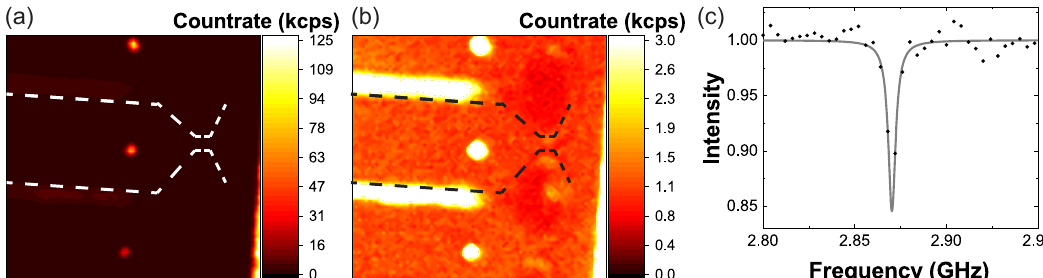
Figure 6. ( a , b ) PL map of SCD platforms with individual nanopillars fabricated with the process described in Section 4. The outer edge of the holding platform is indicated using a dashed line, while the pillars appear as bright spots. To enable comparing the background PL from the platforms with the PL of a few NV − centers in the pillars, we show the same PL map with two different scaling: individual NV − centers in the pillars show PL countrates above 125 kcps at an excitation power of 500 µ W at 532 nm ( a ). ( b ) It is clearly discernible that the cantilevers show only a weak PL of ∼ 1 kcps. The enhanced background in-between the platform arises from a slight roughening between the structures. We detect NV − PL in the wavelength range >650 nm. ( c ) An exemplary optically detected magnetic resonance (ODMR) of one of the NV − centers in the pillar. The resonance (without an external magnetic field) at 2.87 GHz is clearly visible and has a contrast of ∼